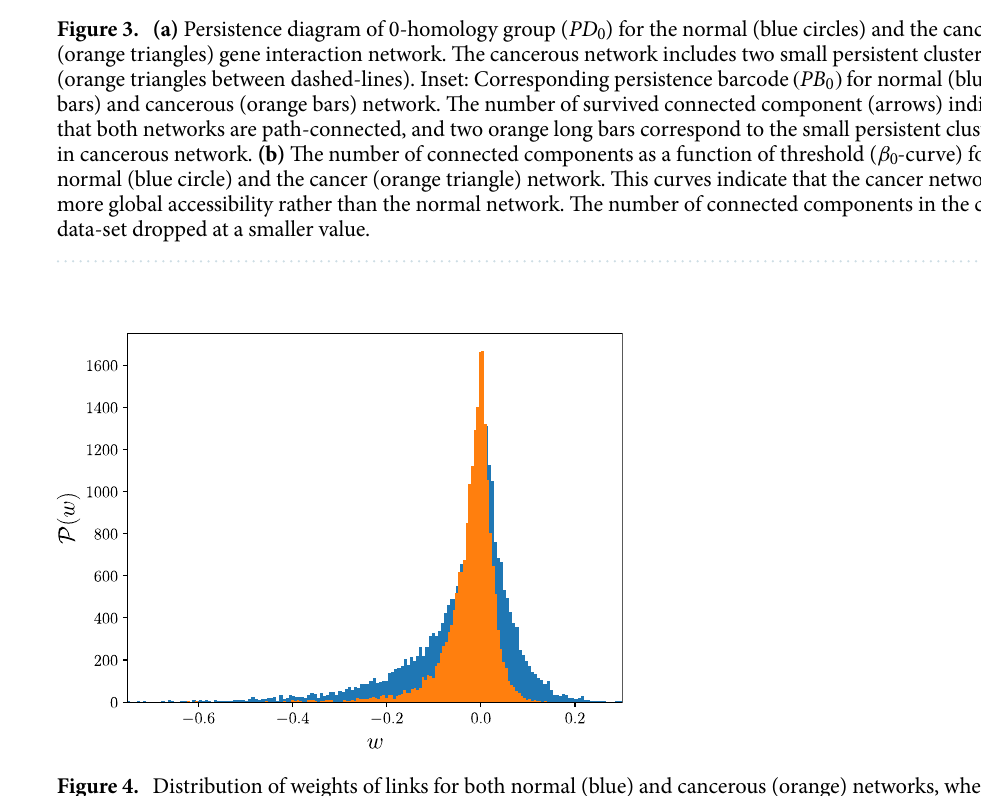
Figure 4. Distribution of weights of links for both normal (blue) and cancerous (orange) networks, where the shorter width of the distribution function of cancerous sample compared to the normal one indicates that the normal network has high-weighted links (tail of the distribution functions) rather than the cancerous